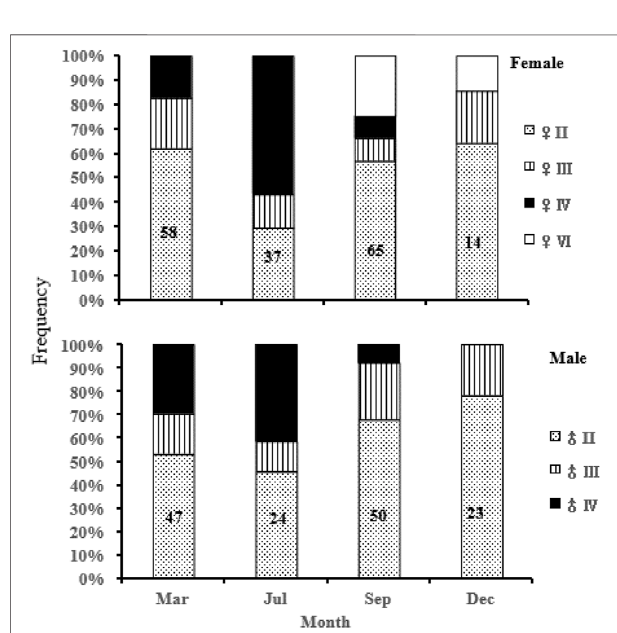
FIGURE 5 | Seasonal gonad stages for female and male S. curriculus in the western Pearl River estuary,